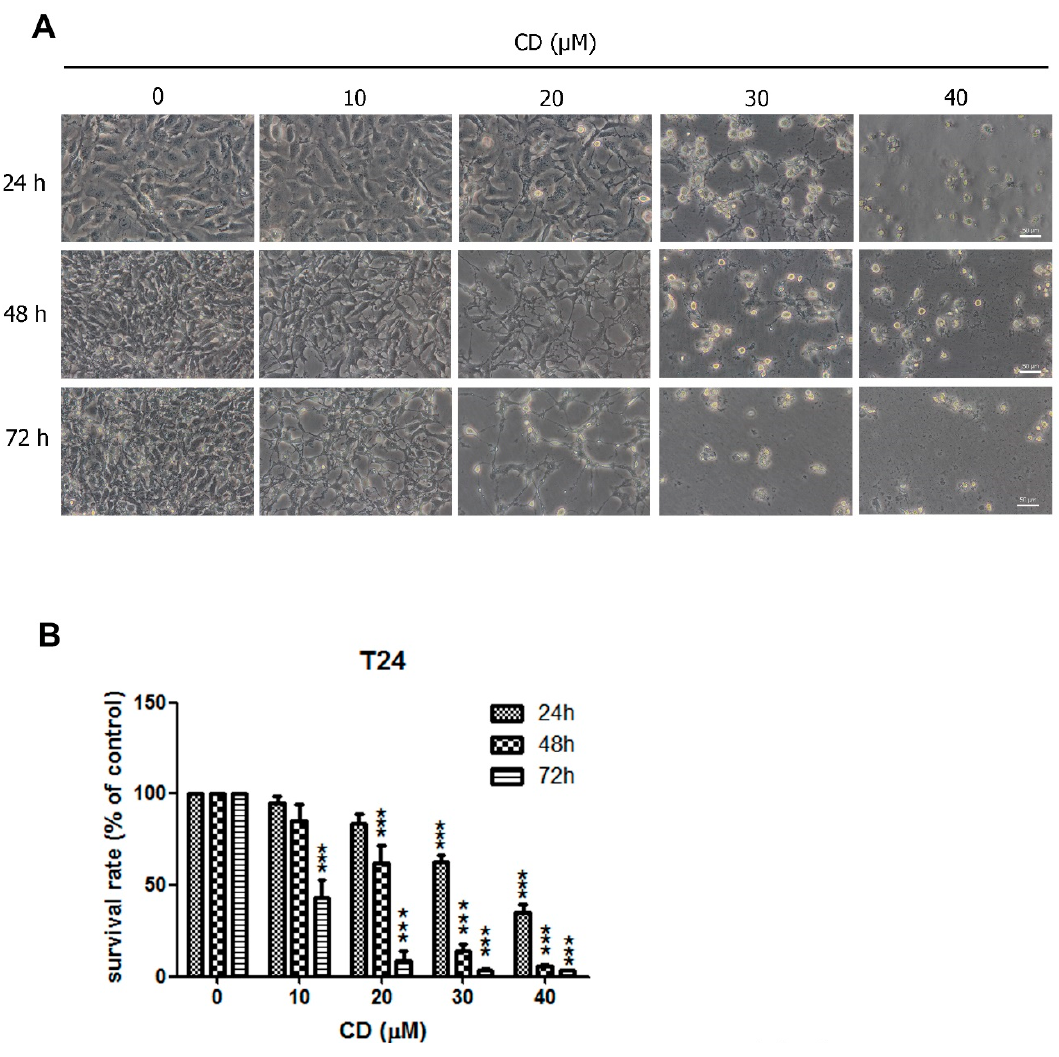
Figure 1. Cytotoxicity induced by CD in T24 BC cells. Cells were treated with different concentrations of CD for 24, 48, and 72 h. ( A ) Cellular morphological changes after treatment with CD. Scale bar = 50 µm. ( B ) Survival rates were examined via MTT assays at 24, 48, and 72 h. *** p < 0.001 as compared with control group (0 µM) in the same time period. Bar graphs show normalised values as percentages relative to the control. Data are expressed as mean ± SD of three independent experiments.